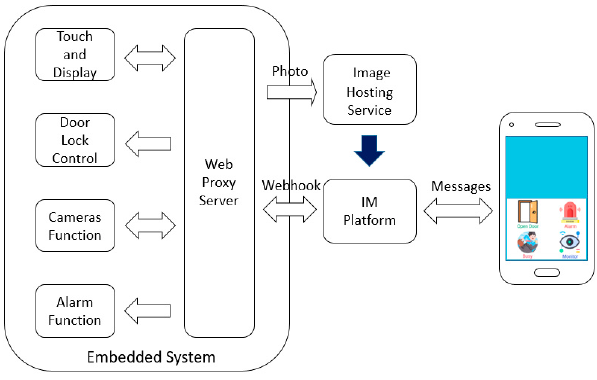
Figure 4. The software framework of this system.